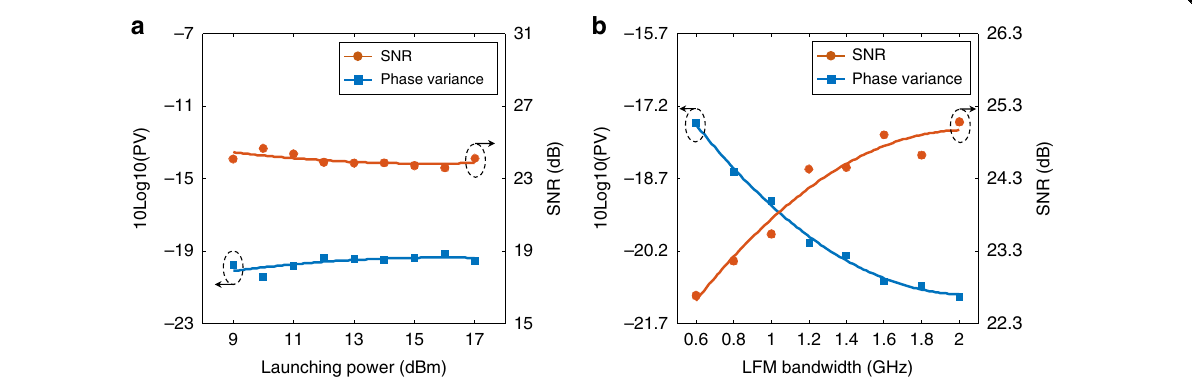
Fig. 7 Effect of the parameters of the transmitted light on the sensing performance. a The effect of the launching power, which is increased from 9 to 17 dBm in a step of 1 dB. b The effect of the LFM bandwidth, which is increased from 0.6 to 2 GHz in steps of 0.2